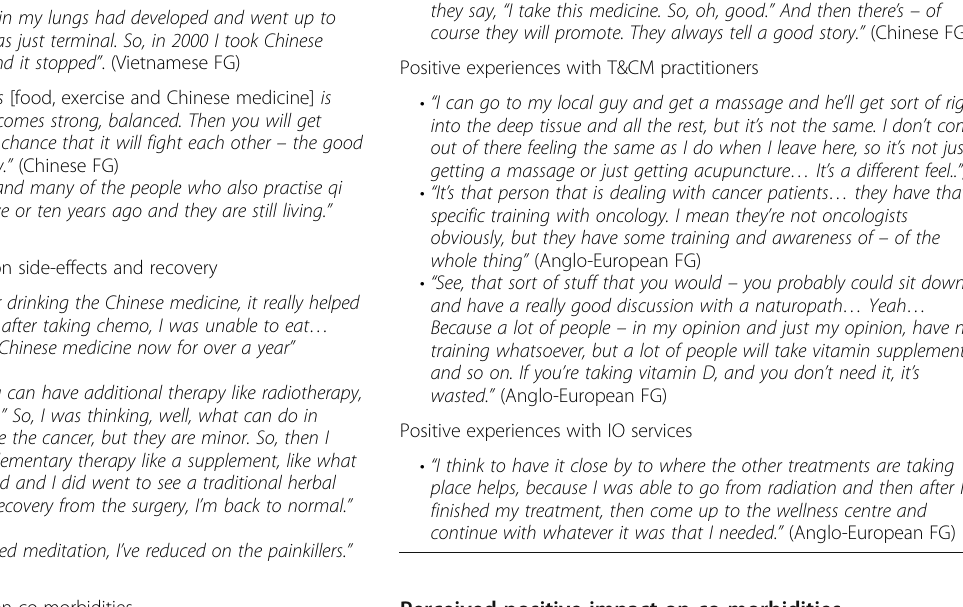
Table 4 THEME 1 - Positive perceptions & experiences Perceived positive impact on cancer survival